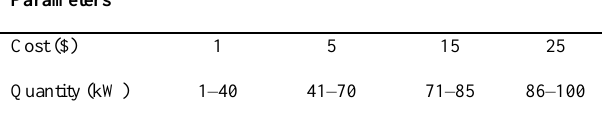
TABLE VI O FFER P RICE FOR L OAD R EDUCTION Q UANTITY